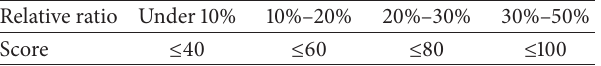
Table 10: Scoring method according to number of longitudinal slope sections.